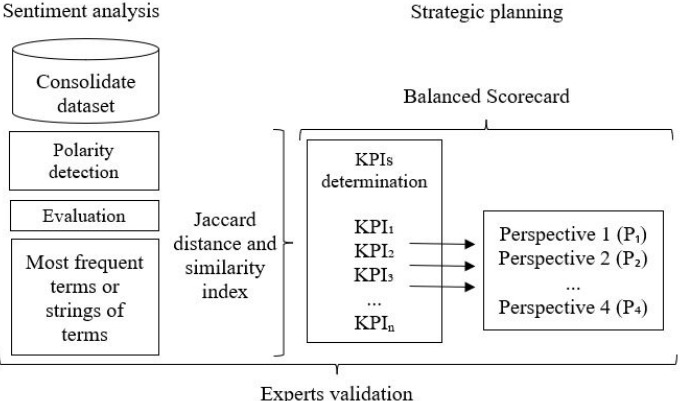
Figure 2. Automatic integration of sentiment analysis and strategic planning.